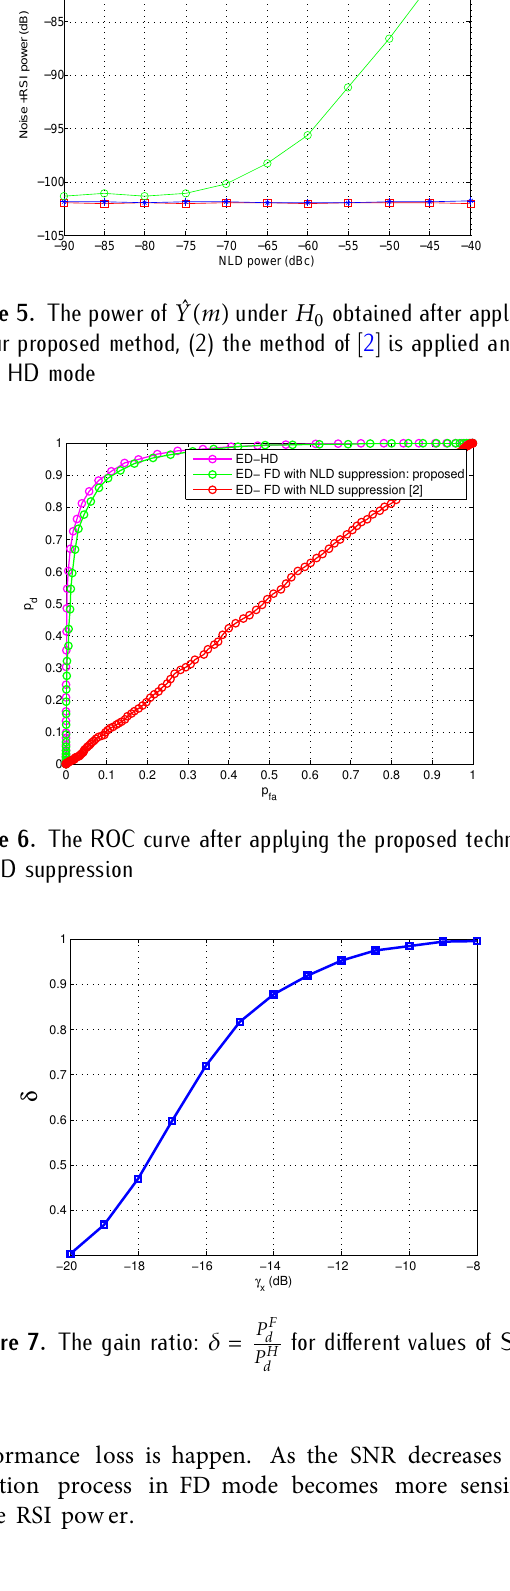
perf ormance loss is happen. As the SNR decreases the detection process in FD mode becomes more sensitiv e to the RSI pow